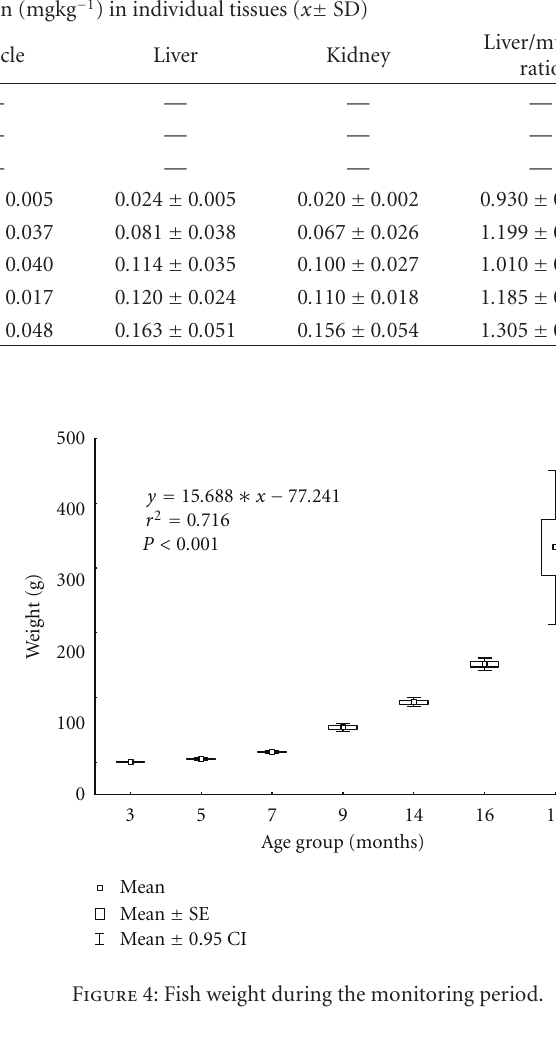
Mercury concentrations in tissues investigated are sum- marized in Table 4. Because of low age and size of fish in groups A–C, it was impossible to determine mercury concentrations in their individual tissues so embryo or whole-body homogenates were used. group D (age 7 months) and the highest in group H (age 18 months). The same holds true for the liver/muscle mercury ratio (Table 4). Average mercury concentrations in muscle, liver,